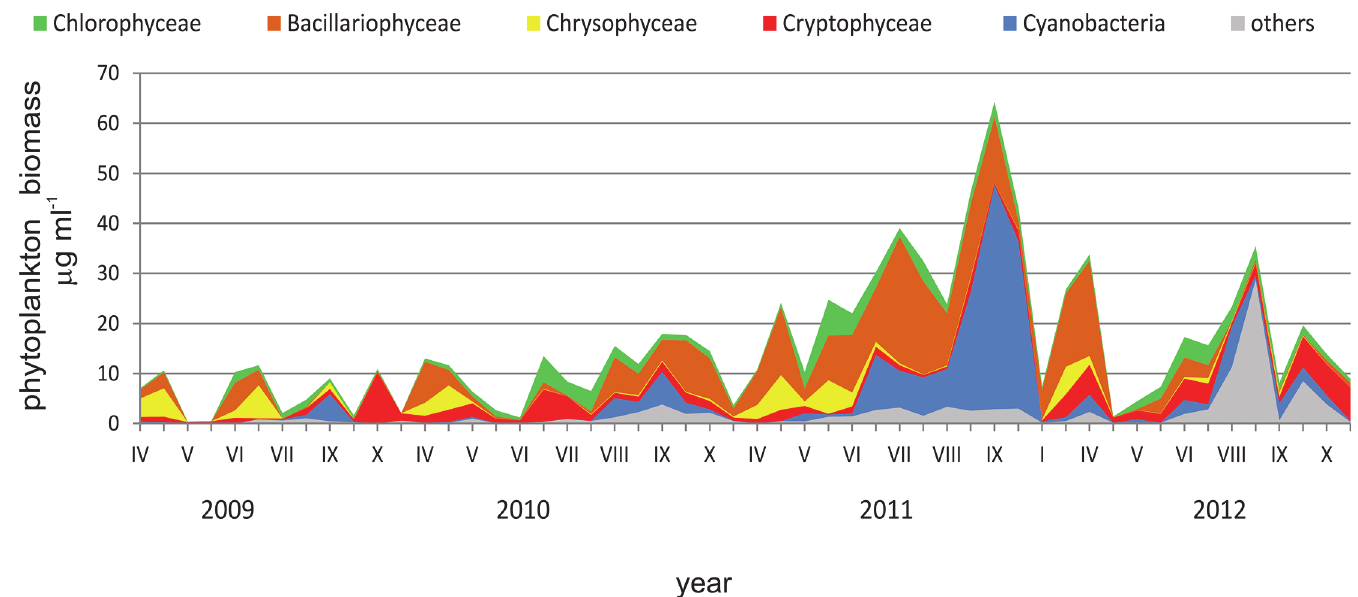
Fig 7. The biomass of phytoplankton groups in the investigated period (an example from the depth of 1